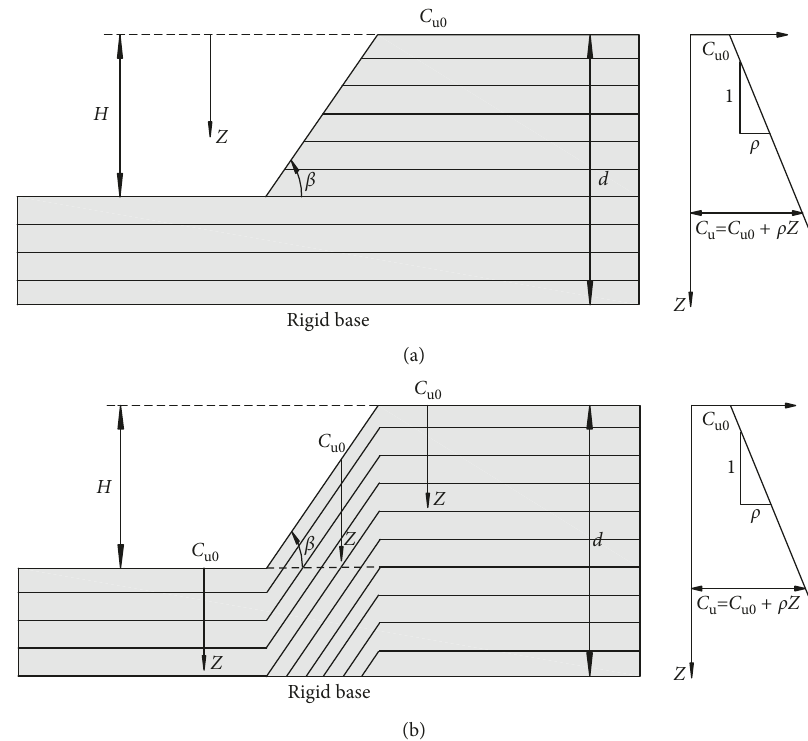
Figure 1: Depth contours and undrained strength profile assumed representative of (a) a cut slope and (b) a natural slope (adopted from the study of Li et al.,